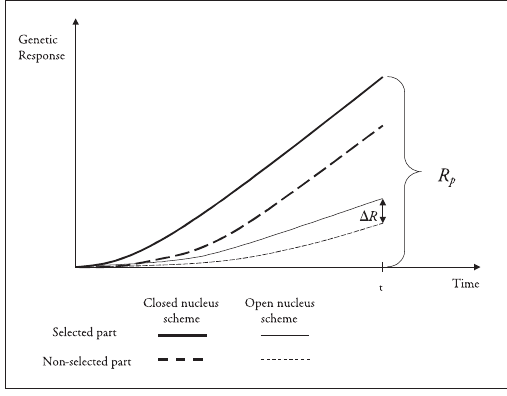
Predicted development of selection response for a one-way (closed nucleus scheme) and two-way gene flow (open nucleus scheme) between a selected and a non-selected subpopulation. The response in the closed selected subpopulation represents the potential response ( R p ). In the case of the open selection scheme, the upper of the two lines is the outlined development in Sel and the lower line corresponds to Cont. (cid:3) R is the realized difference in genetic response between the selected and non-selected parts in year